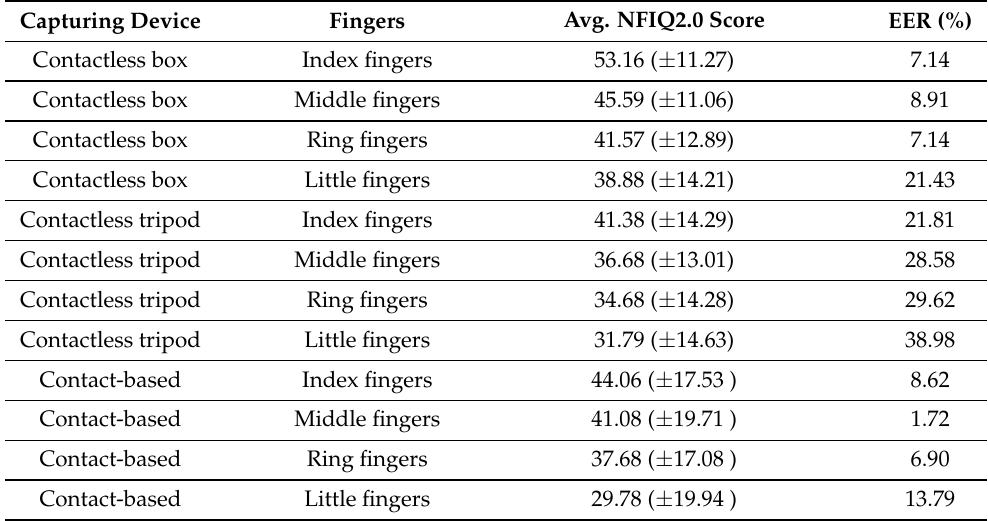
Figure 10. Averaged NFIQ2.0 scores obtained from the considered databases: average over all fingers (IDs 2–4, 6–10), index fingers (IDs 2, 7), middle fingers (IDs 3, 8), ring fingers (IDs 4, 9), and little fingers (IDs 5, 10). Table 5. Overview of the NFIQ2.0 quality scores and the EER of individual fingers: index fingers (IDs 2, 7), middle fingers (IDs 3, 8), ring fingers (IDs 4, 9), and little fingers (IDs 5, 10).